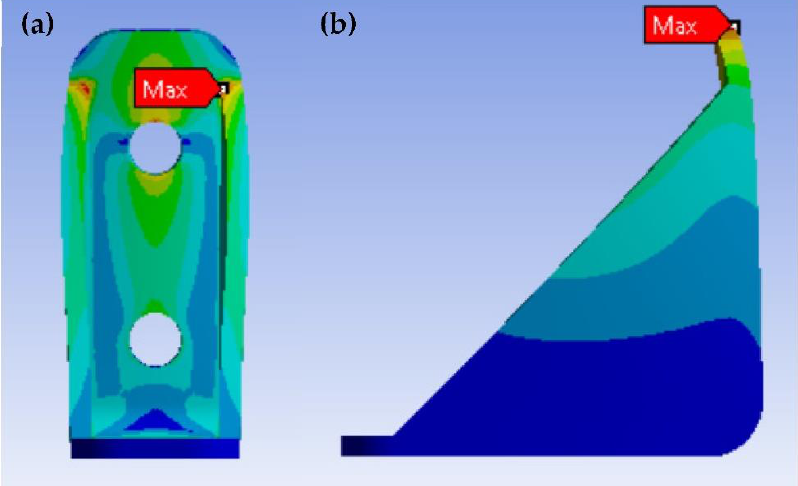
Figure 8. Simulation results of Mode-3 showing ( a ) maximum stress and ( b ) maximum deformation.